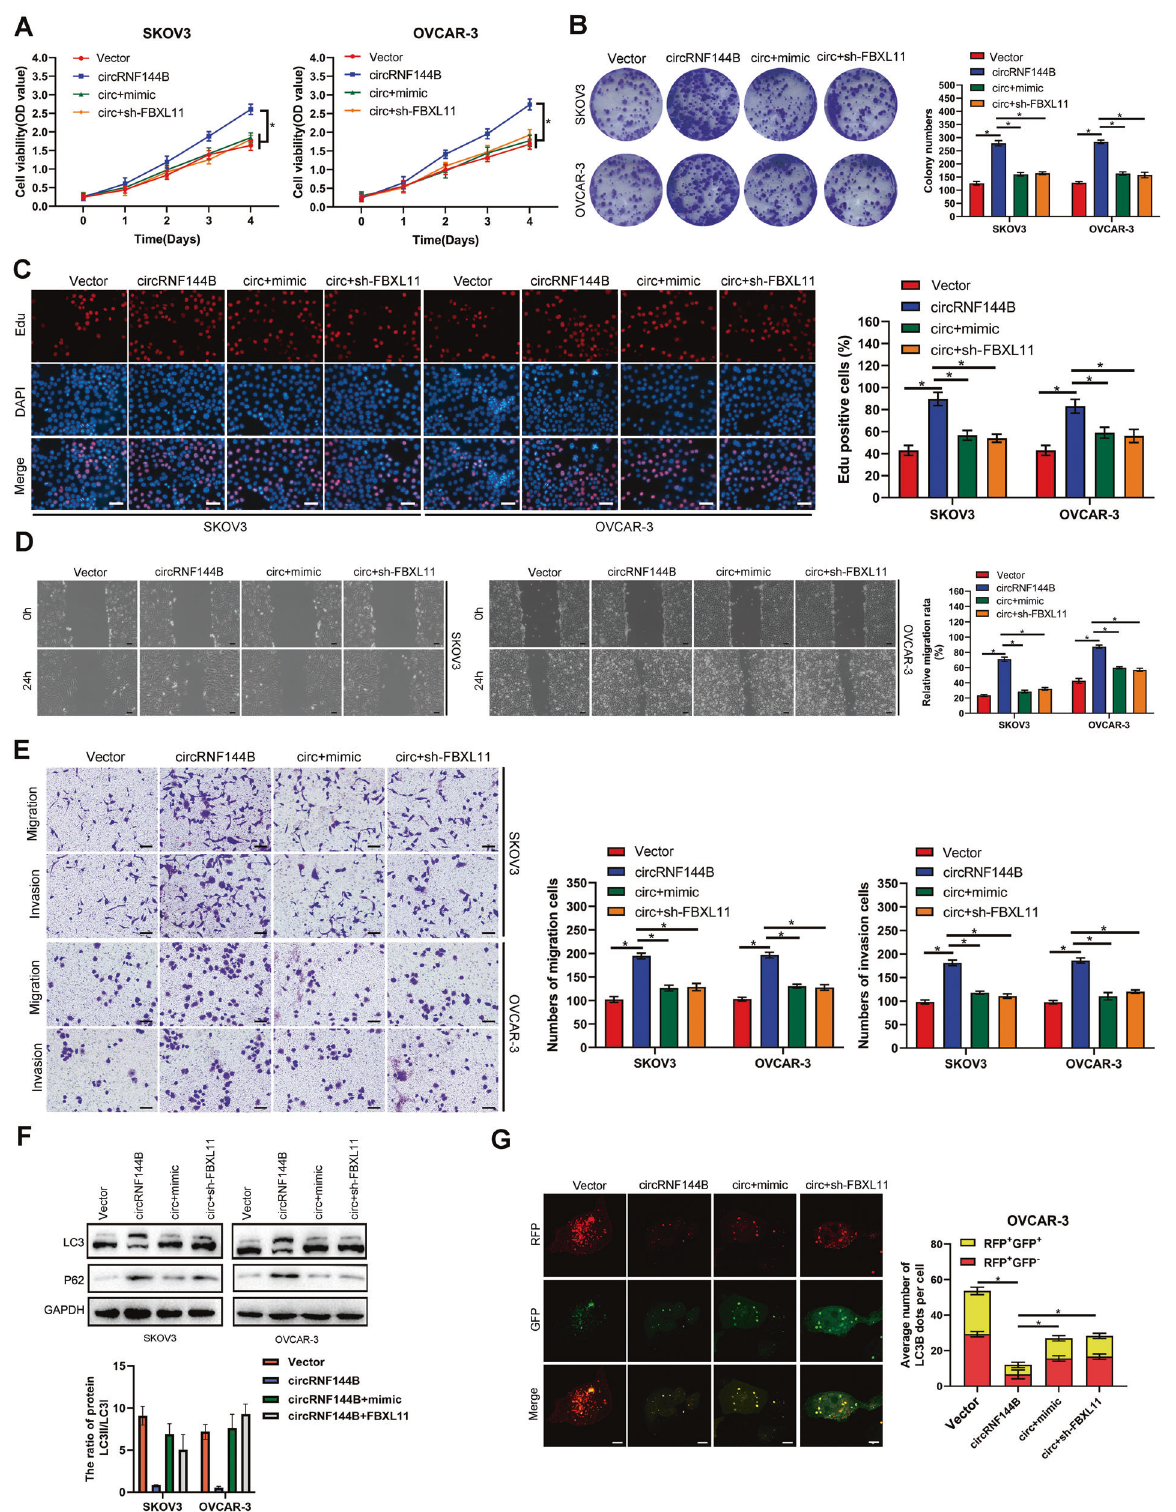
Fig. 6 Effects of circRNF144B was dependent on miR-342-3p/FBXL11 axis. MiR-342-3p was overexpressed, and FBXL11 was suppressed in SKOV3 and OVCAR-3 cells. A The CCK-8 assay was used to detect cell viability in each group. B Colony formation assay was used to detect colony formation in each group. C EDU positive rate in each group was detected. Scale bar, 100 μ m. D Wound healing assay was used to detect cell migration in each group. Scale bar, 50 μ m. E Transwell assay was used to detect cell invasion in each group. Scale bar, 50 μ m. F Western blotting was used to detect LC3 and P62 in each group. G Confocal microscopy was used to detect the number of autophagosomes and autophagolysosomes in each group. Scale bar, 25 μ m. *, P < 0.05; **, P < 0.01.